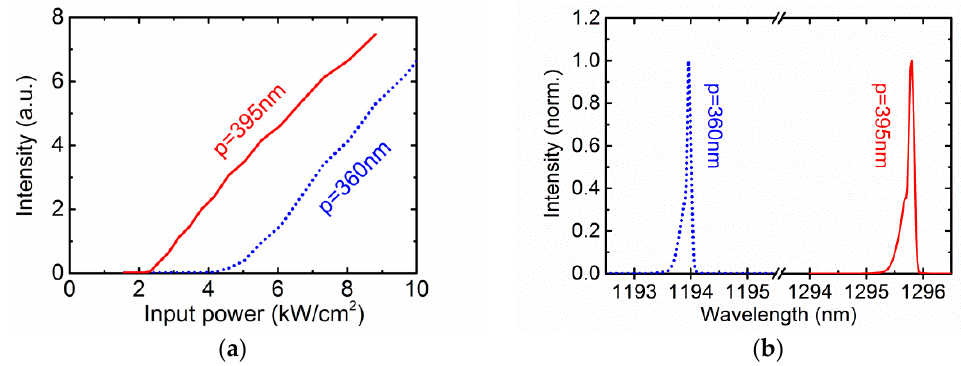
Figure 5. ( a ) Light-light ( L-L ) curves and ( b ) lasing spectra of QD PCSELs with periods of 360 nm and 395